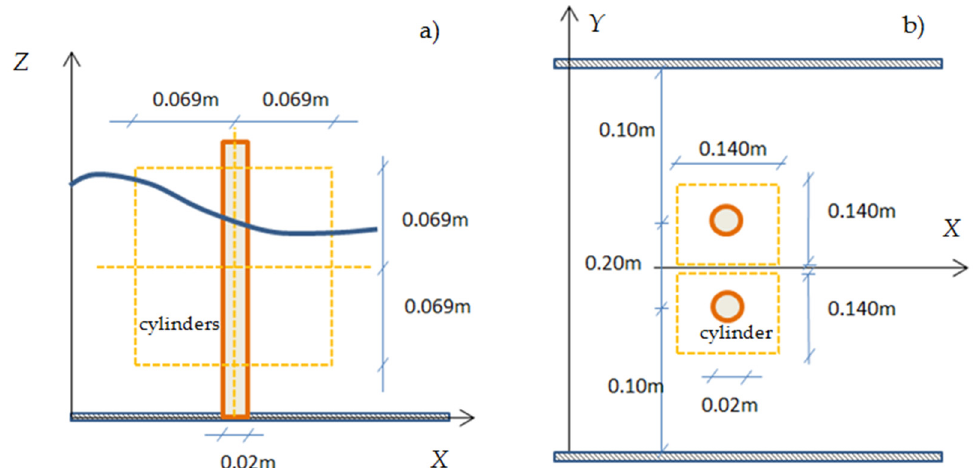
Figure 2. Sketch of the longitudinal ( a ) and plan view ( b ) of the cylinders in the flume with the fixed coordinate system ( X , Y , Z ). Dashed lines define the field of views (FoV) of the PIV. Measurements not to scale.